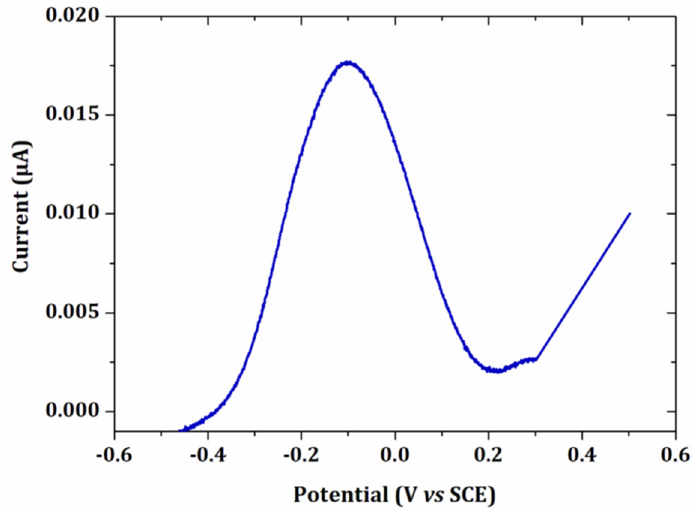
Figure 8. Linear voltammetry of 15 μ mol L − 1 PbCl 2 in 0.1 mol L − 1 NaCl after an electrodeposition at − 0.5 V/SCE for 90 s. Scan rate: 100 mV s − 1 . Electrode surface: 0.002 cm².